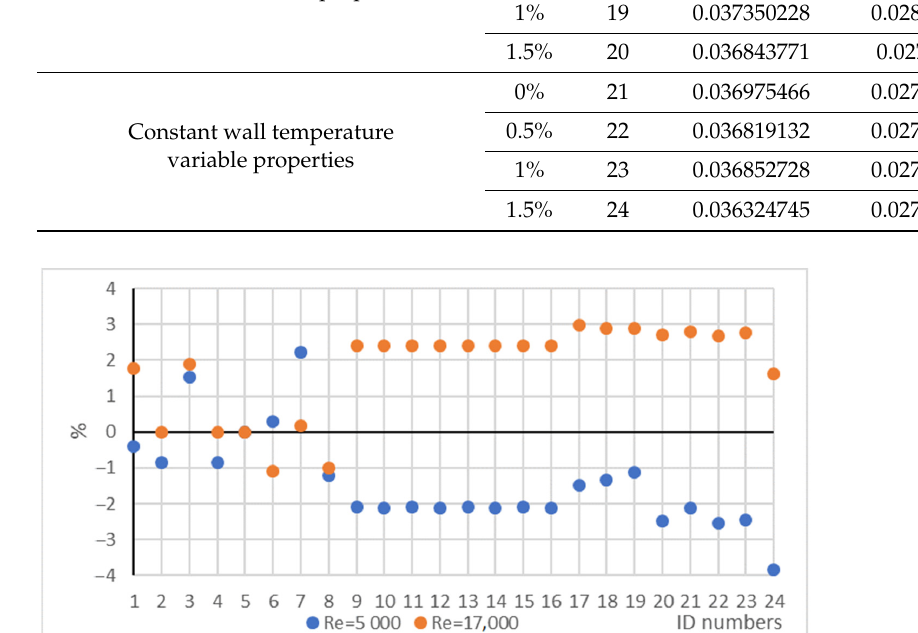
Figure 13. Percentage differences from the Prandtl–Kármán–Nikuradse friction factor.